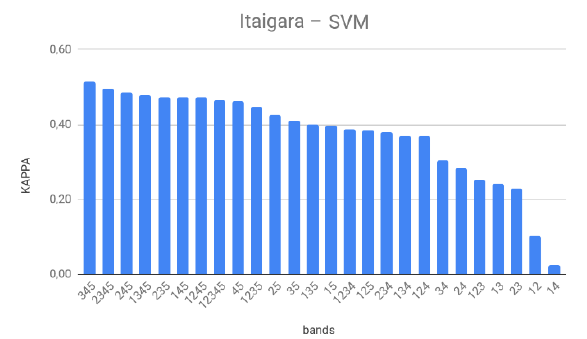
Figure 4 . Variation of the cover index due to the combination of bands in the Itaigara